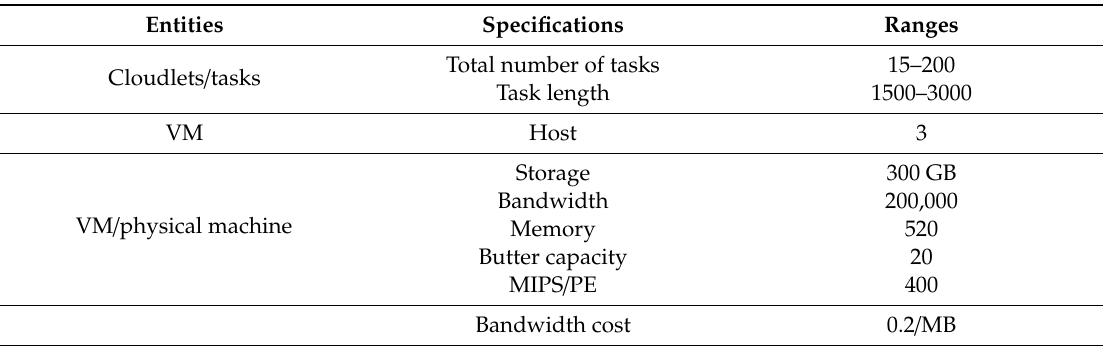
Table 2. Parameters required in